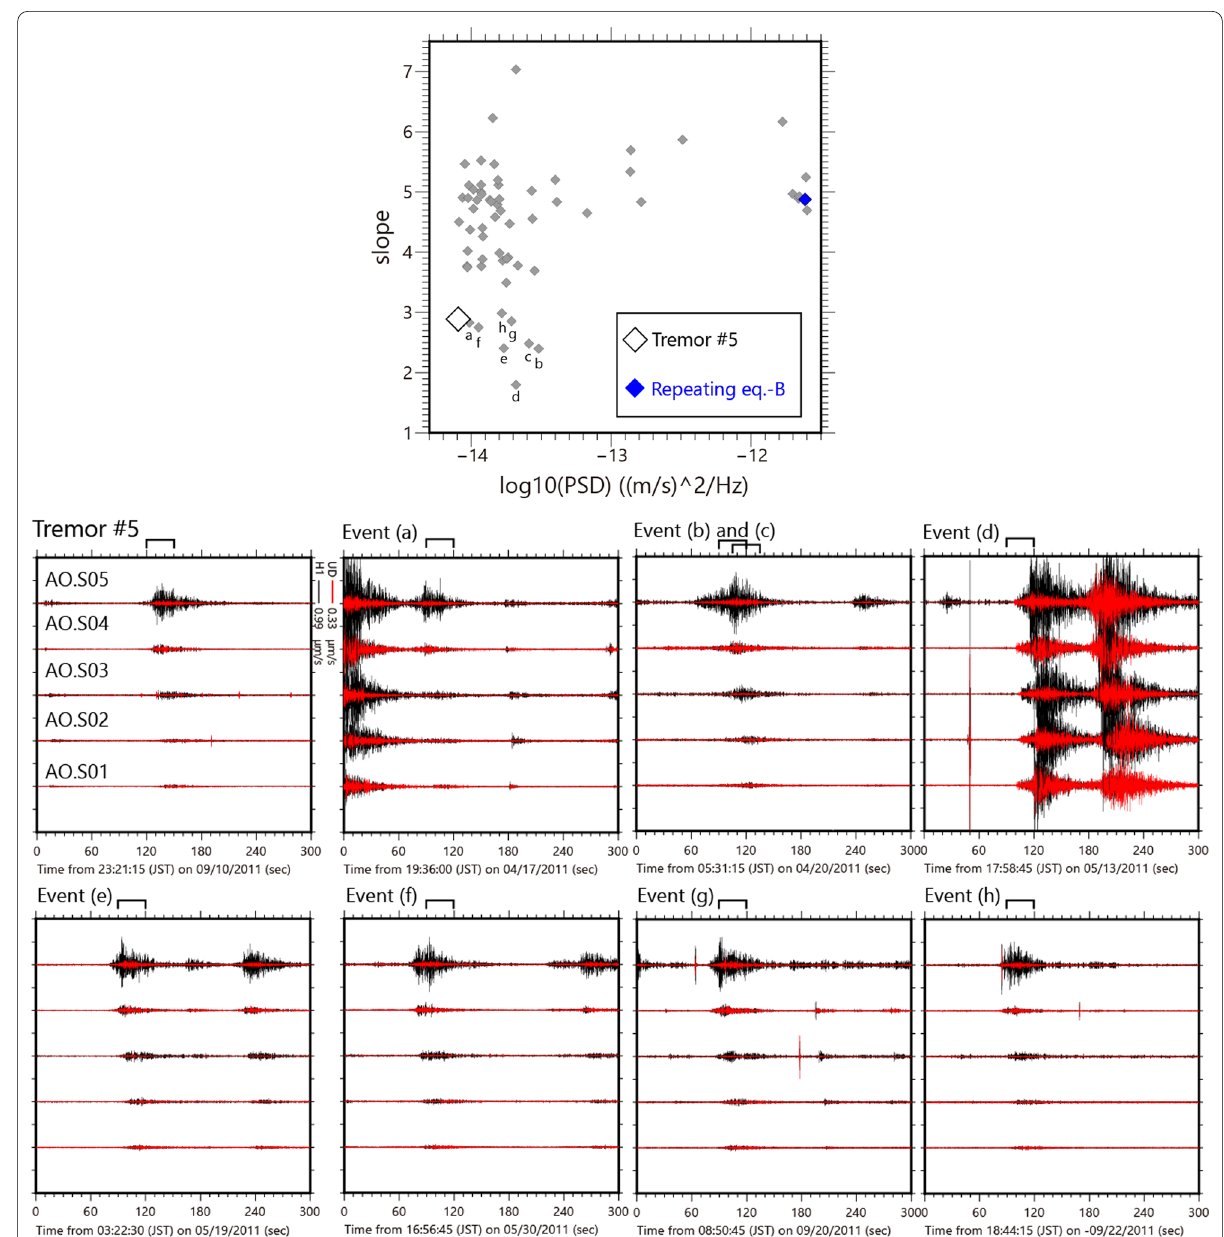
Fig. 9 Relationship between slope of power spectral density at 1–4 Hz, and average of power at 2–4 Hz band for the events with amplitude deviation smaller than the tremor detection threshold. The waveforms of the events showing power spectral density slopes similar to or smaller than that of tremor #5 (indicated as a to h in the top panel) are shown in the bottom two rows. The red and black lines show vertical and horizontal components, respectively. The brackets show the locations of the detection